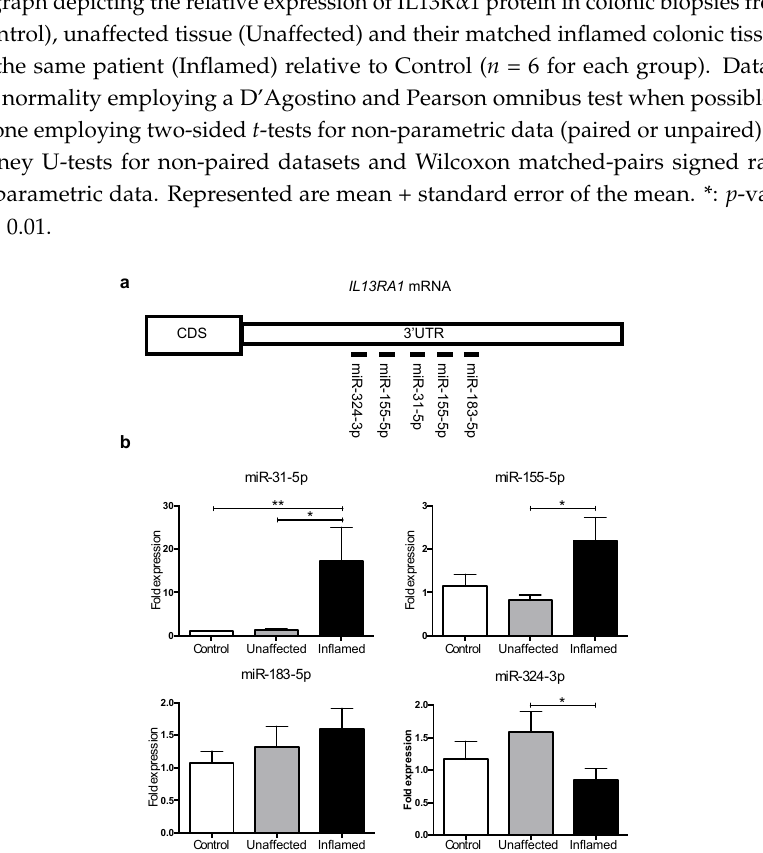
Figure 2. MicroRNAs predicted to target IL13RA1 mRNA expression levels in UC colonic biopsies: ( a ) Schematic of the 3 ′ UTR of IL13RA1 mRNA representing the approximate locations for predicted (validated for miR-155) miR binding sites (Table S1); and ( b ) Bar graphs depicting the expression levels of miR-31-5p, miR-155-5p, miR-183-5p and miR-324-3p in colonic biopsies from non-UC patients (Control), unaffected tissue (Unaffected) and their matched inflamed colonic tissue samples taken from the same patient (Inflamed) ( n = 7 on each group) relative to Control. Represented are mean + standard error of the mean. Data were normalised to expression of small nucleolar RNA C/D Box 44 (RNU44) prior to performing one-sided t -tests (paired for Unaffected vs. Inflamed or unpaired when comparing against Control). *: p -value ≤ 0.05; **: p -value ≤